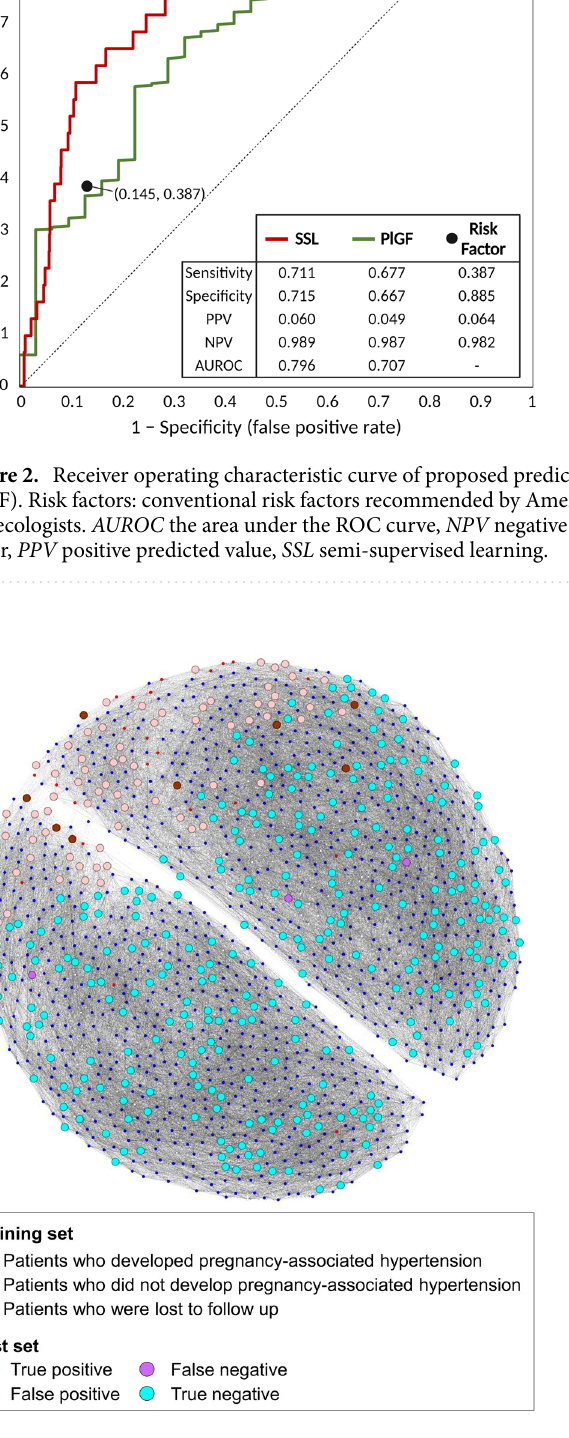
Figure 3. The patient-derived network with 1404 pregnant women. Training set (enrolled in 2014–2017); Test set (enrolled in